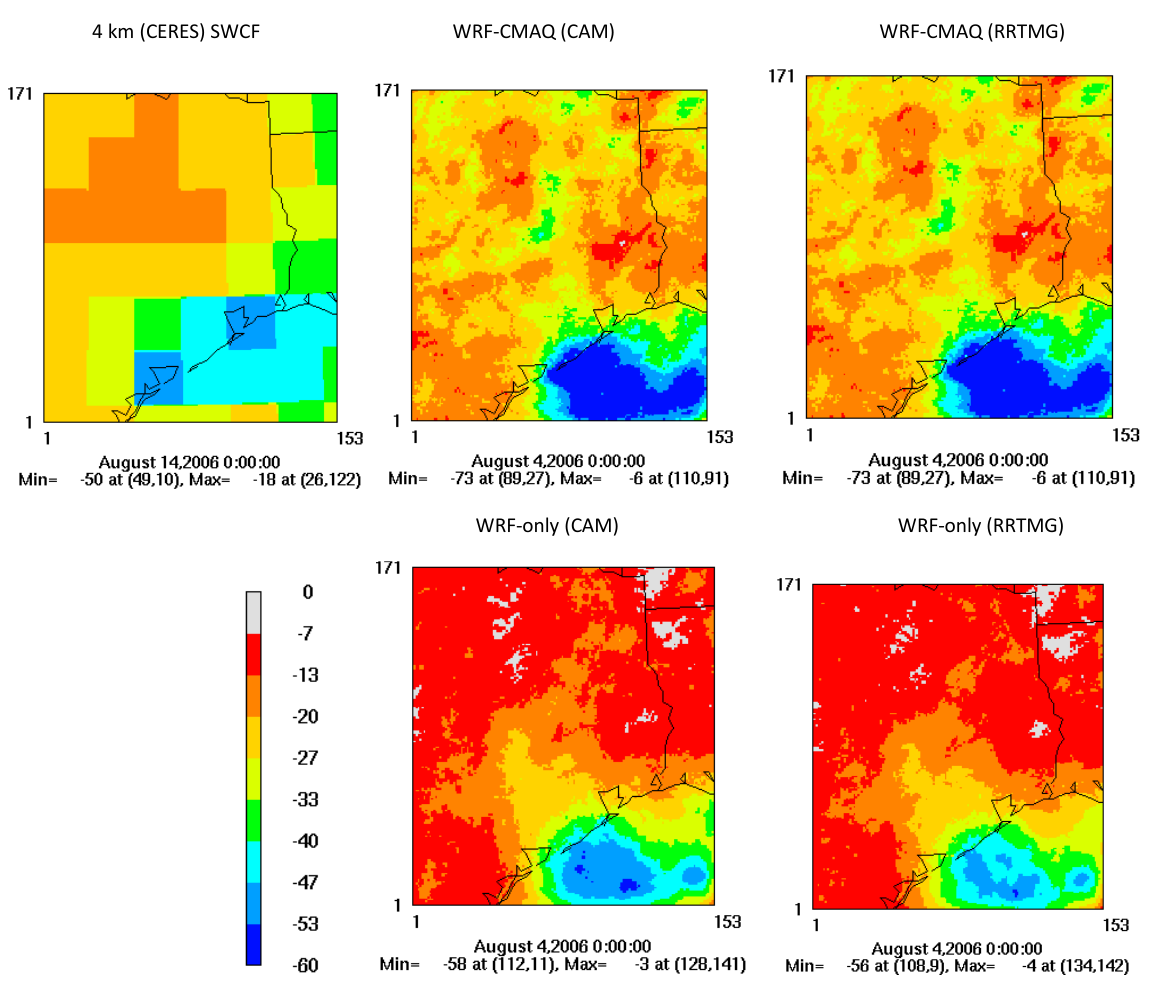
Figure 10. Same as Figure 9 but for the eastern Texas domain on the basis of the 4-km resolution simulation for August of 2006.